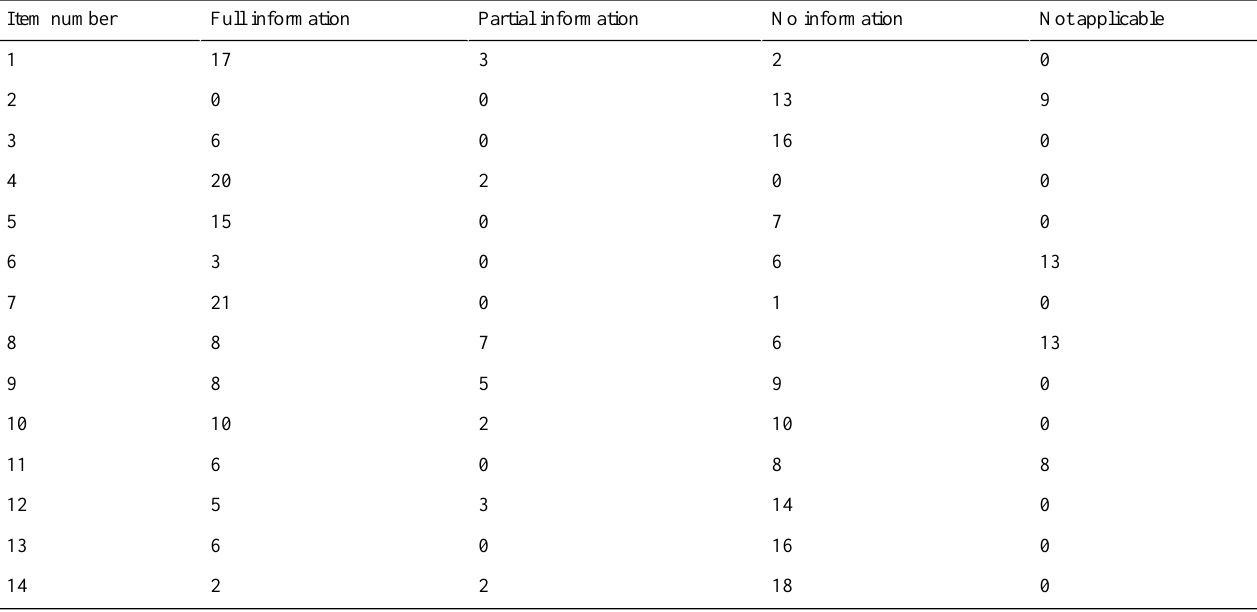
Table 7. Summary of compliance with General Data Protection Regulation